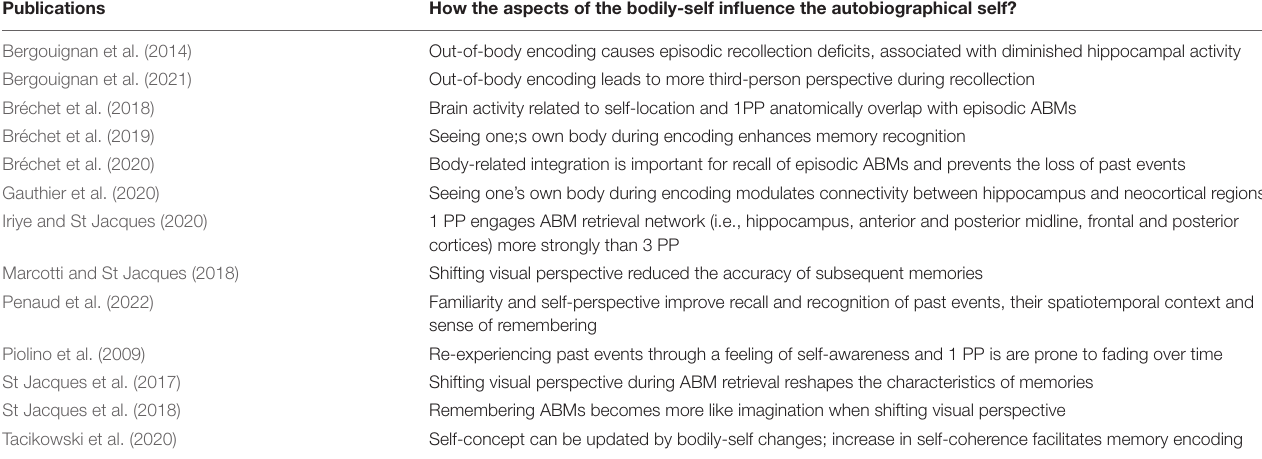
TABLE 1 | Studies examining the relationship between bodily-self and autobiographical-self.